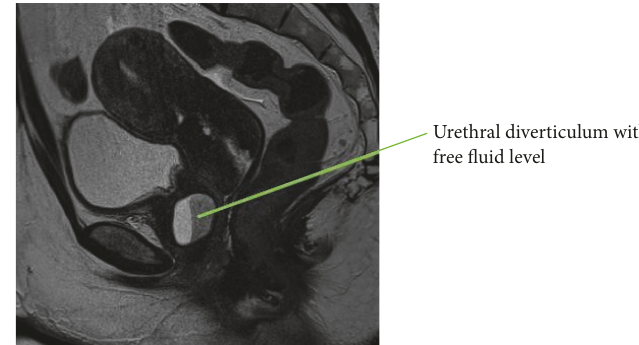
Figure 2: Pelvic MRI, sagittal view of urethral